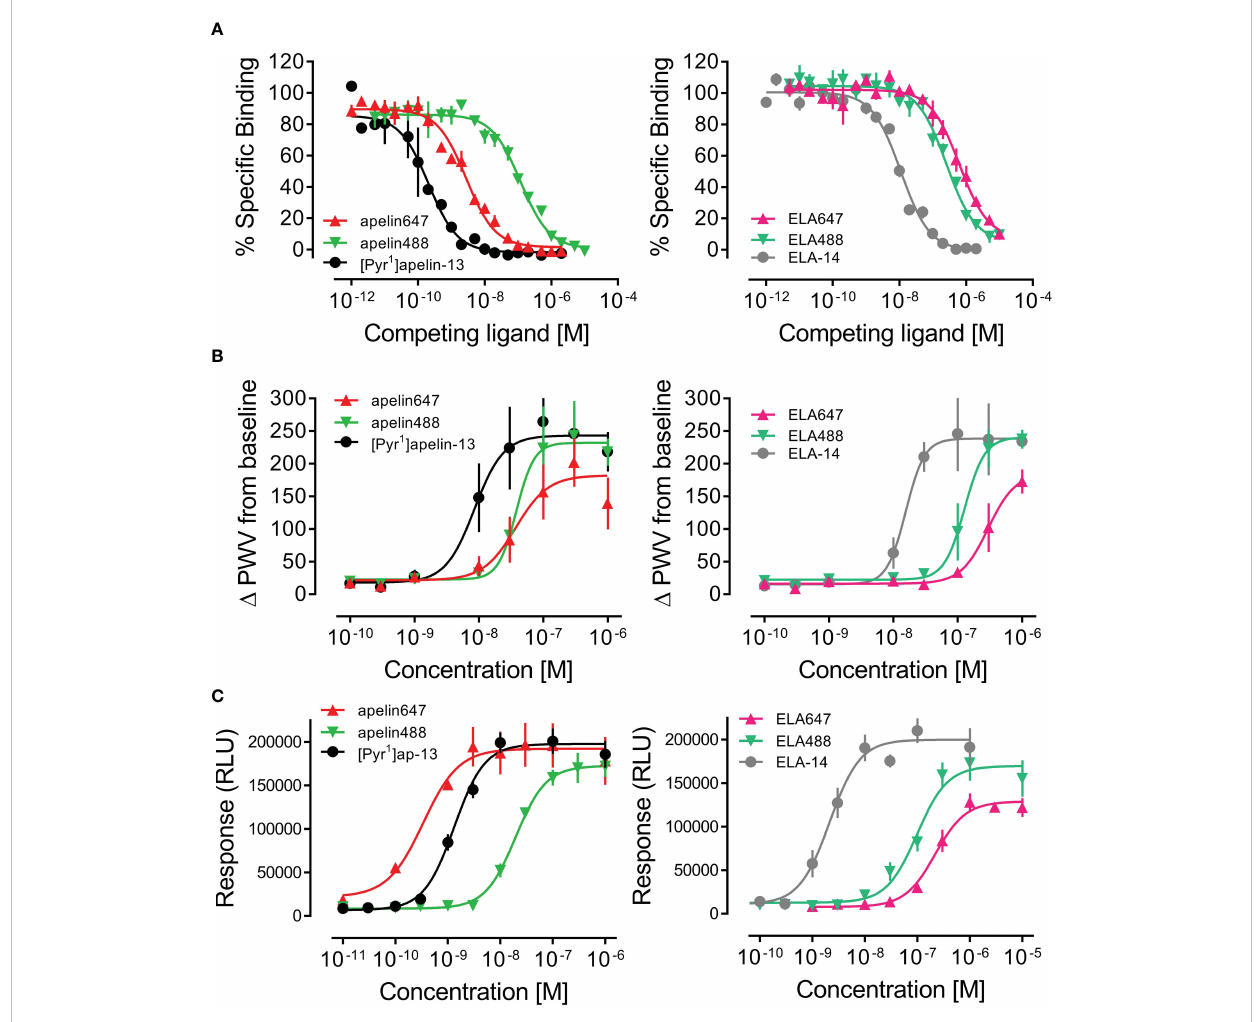
FIGURE 2 In vitro pharmacological validation of fl uorescent apelin receptor ligands. (A) Competition binding curves show speci fi c binding of apelin ligands (left) and ELA ligands (right) against a 0.1 nM concentration of [ 125 I]-apelin-13 in human left ventricle tissue homogenate (1.5 mg/mL protein). (B) Concentration-response curves for apelin ligands (left) and ELA ligands (right) in an in vitro dynamic mass redistribution assay, showing response as change in peak wavelength value ( D PWV) from baseline. Data are expressed as mean ± s.e.m., n = 3. (C) Concentration-response curves for apelin ligands (left) and ELA ligands (right) in an in vitro internalisation assay, showing response in relative light units (RLU). Data are expressed as mean ± s.e.m., n = 3. In all panels, left column shows [Pyr 1 ]apelin-13 = ● , apelin488 = ▼ , apelin647 = ▲ , and right column shows ELA-14 = ● , ELA488 = ▼ , ELA647 = ▲